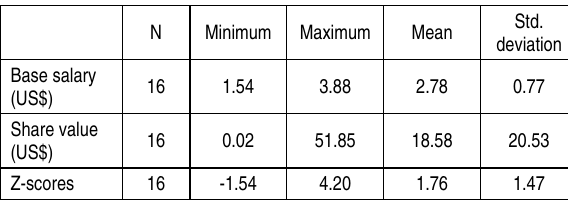
Table 1. Descriptive statistics from